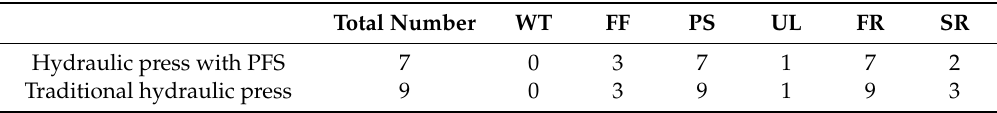
Table 4. Compositions of the drive system and the number of motor pumps used in di ff erent operations. WT: waiting within a working cycle, Stages 1 and 8, WT; FF: fast falling, Stage 2; UL: unloading, Stage 5; FR: fast returning, Stage 6; SR: slow returning, Stage